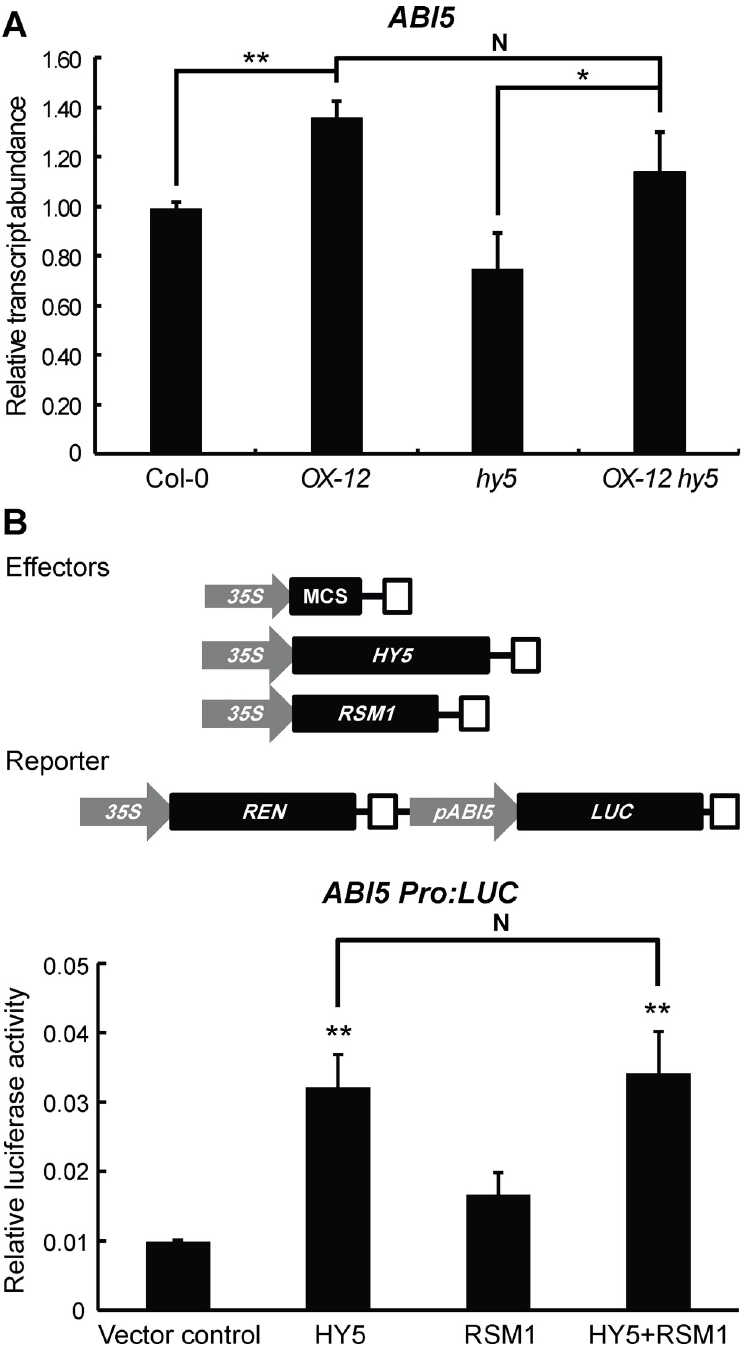
Fig 10. HY5 and RSM1 in regulating ABI5 trascription. (A) HY5 and RSM1 in regulating ABI5 trascript level in qRT-PCR assays. Col-0 WT seeds were germinated on MS medium for 3 h before harvested for RNA extraction and qRT-PCR. Information of the primers used in this assay is available in S7 Table. ACT2 was used as a control for data normalization. Three independent replicates of measurements were performed for each genotype, and the data are shown as the mean ± standard deviation (SD) (n = 3). � p < 0.05 and �� p < 0.01 represent significance of the differences between each pair of genotypes, N indicates that no significant difference was found between this pair of genotypes. (B) HY5 and RSM1 in regulating ABI5 transcription in dual-luciferase transient expression assays. Upper panel: Schematic diagram of effector and reporter constructs. The rectangles filled with white stand for CaMV terminator. MCS (multiple clonal site) as the empty vector control, HY5, and RSM1 were driven by a full-length cauliflower mosaic